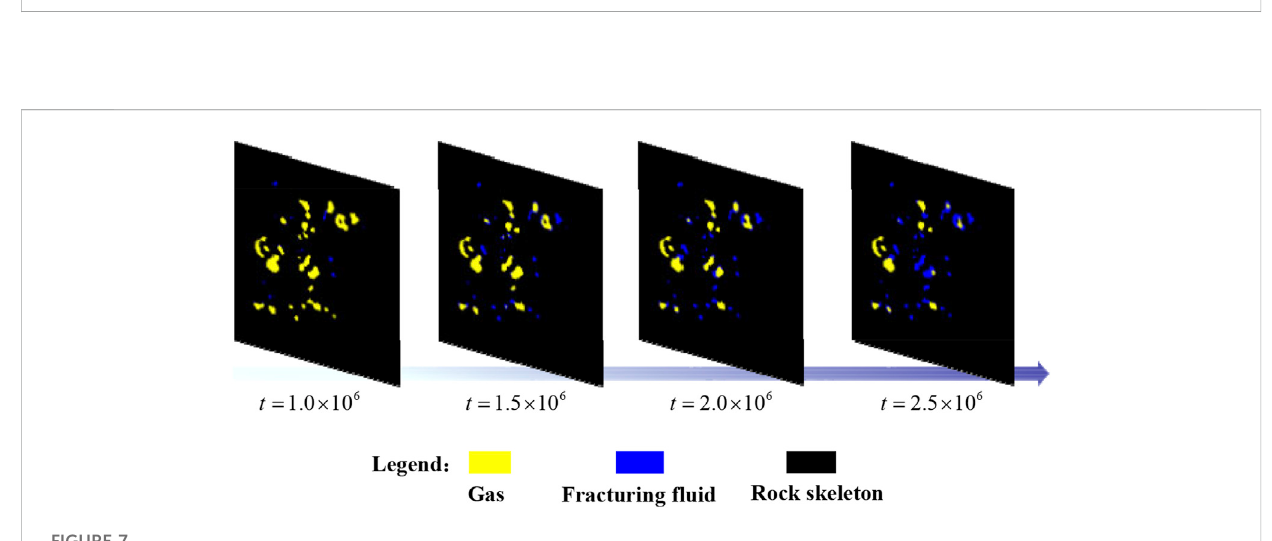
FIGURE 7 Gas-liquid distribution of slice 3 in Figure 6 at different time